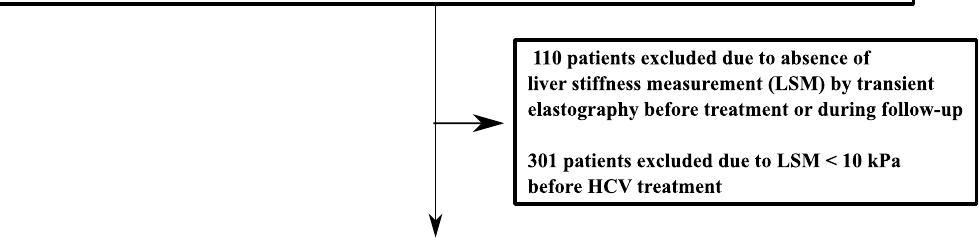
Figure 1. Study flowchart for inclusion of